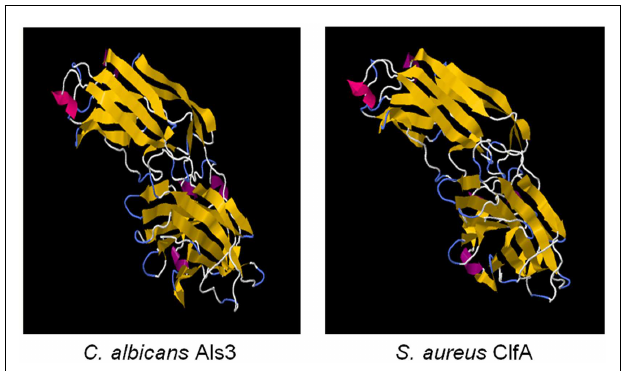
FIGURE 2 |The cross-kingdom immunogen rAls3 based on structure/function homology is shown . Illustrated here are structurally homologous regions in Als3 ( C. albicans adhesin/invasin; model) and ClfA proteins ( S. aureus adhesin; deterministic structure analysis).The structural model of the Als3 N-terminus was generated as previously described using sequence threading and molecular dynamics [ left ; (130, 131)].The cognate region in a homolog from S. aureus (clumping factor A; ClfA; right ) is shown for comparison. Both proteins are members of the immunoglobulin superfamily and known virulence determinants. Note the overall highly similar three-dimensional β -barrel domains (gold arrows), interposed by hinge regions.